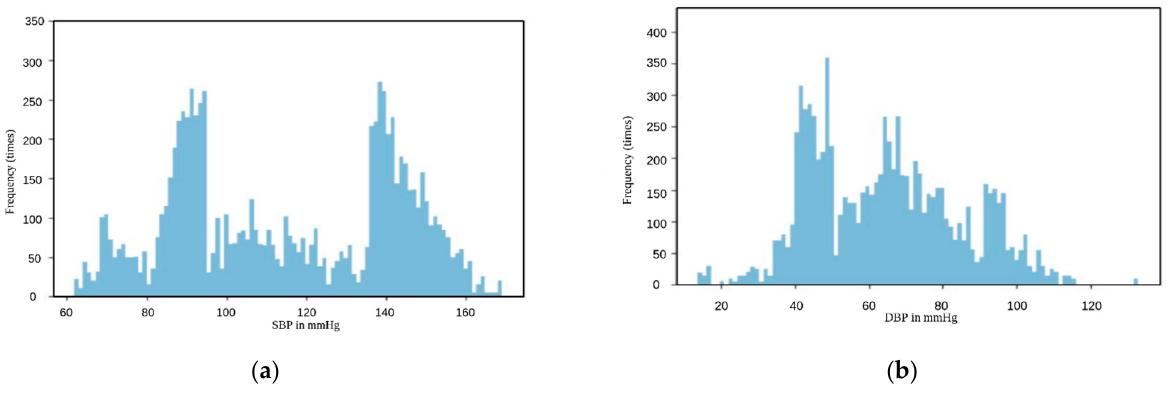
Figure 2. Distribution of the samples in the training sets after upsampling: ( a ) distribution of sam- ples used to train models to estimate SBP; ( b ) distribution of samples used to train models to esti- mate DBP.